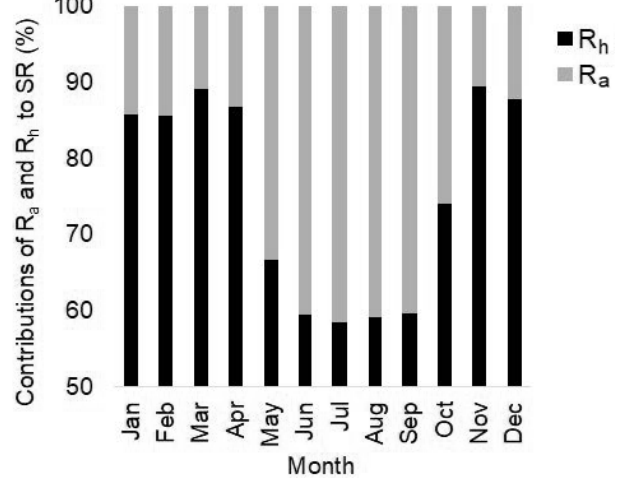
Figure 5. Modeled contributions of autotrophic ( R a ) and het- erotrophic ( R h ) respiration to total